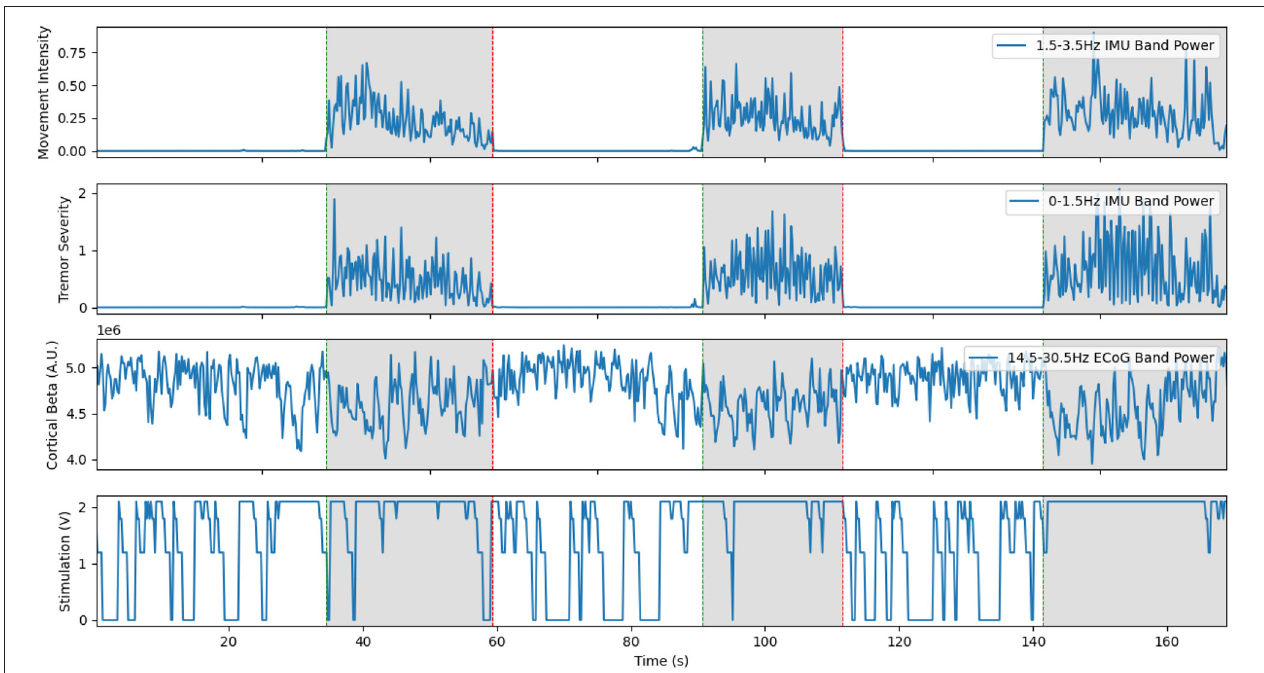
FIGURE 6 | Representative trial of the fully implanted aDBS system with Patient 2. Since the classifier is strongly biased towards having stimulation on, the stimulator turns on even during rest. Unlike the previous examples, the cortical beta shown here is the power band estimate computed online by the Activa PC+S during the experiment. Although this is more noisy than the offline spectra, the system was able to respond very quickly to the onset of movement and turn on stimulation. This is a re-illustration of the results in Ferleger et al.